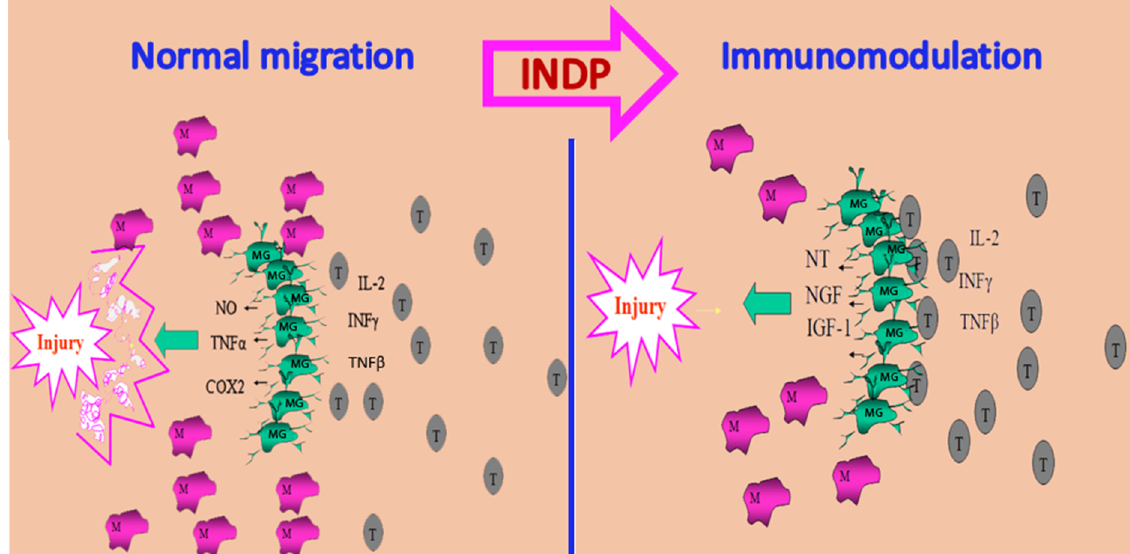
Figure 1. INDP promotes neuroprotection. After SCI microglia are activated as an M1 phenotype characterized by releasing cytotoxic substances and participating in tissue destruction. These cells are unable to interact with adaptive immunity, an important condition to promote neuroprotection. In the same circumstances, T lymphocytes are recruited in small amounts and very late, collaborating then, to intensify tissue damage. INDP induces an early and abundant recruitment of T cells allowing the activation of microglia under the M2 phenotype and promoting then neuroprotection. NO: nitric oxide; M: peripheral macrophages; MG: microglia; T: T lymphocytes; IL-2: interleukin-2; NT: neurotrophins; IGF-1: insulin-like growth factor-1 Note. Adapted from “Immunization with neural-derived peptides as a potential therapy in neurodegenerative diseases” by Mestre H, Ibarra A. In: Chang RCC, editor. Neurodegenerative diseases-processes, prevention, protection and monitoring. InTech; 2011 (https://www.intechopen.com/chapters/24852). CC